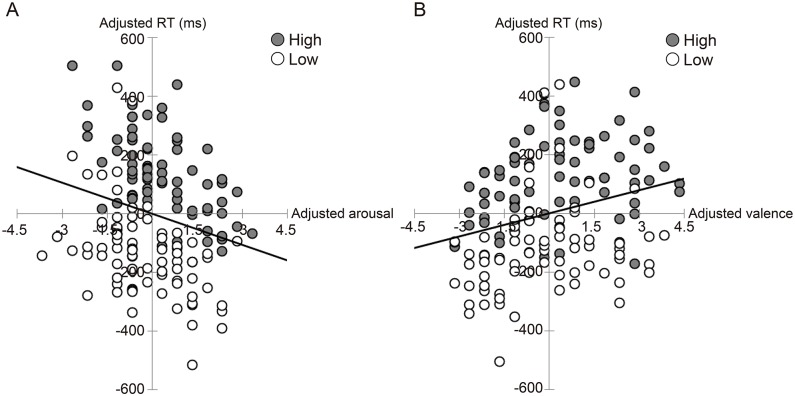
The relationship between emotional arousal and RT (A) and between emotional valence and RT (B).Gray circles and white circles represent data from the high- and low-neuroticism groups, respectively. Scatter plots and regression lines represent the relationships between the ratings and RTs after partialling out the participant effect and subtracting the means of the RTs and ratings.